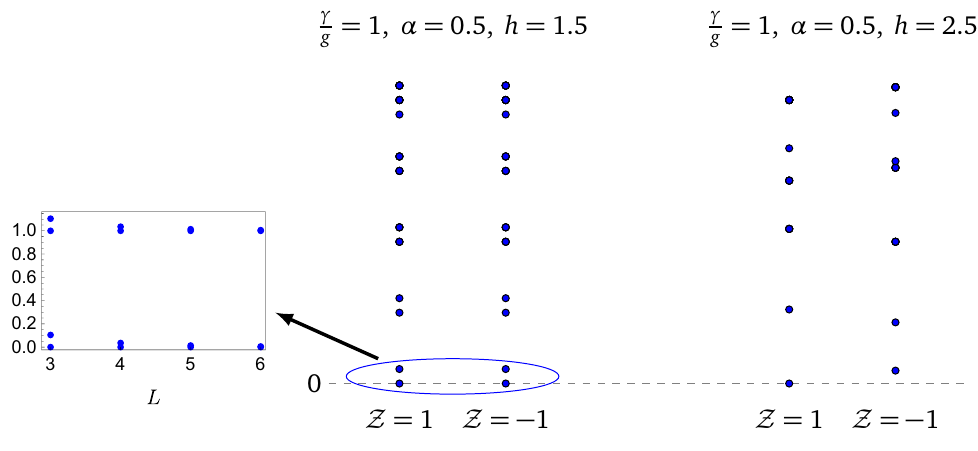
Figure 4: (Negated real part of the) spectrum of the Liouvillian for the topologi- cal model with open boundary conditions, split according to the value of the parity Z = ± 1, for values of the parameters inside the topological (left) or topologically trivial (right) phase. In the former case, the inset shows the first two eigenvalues in both sectors for increasing system